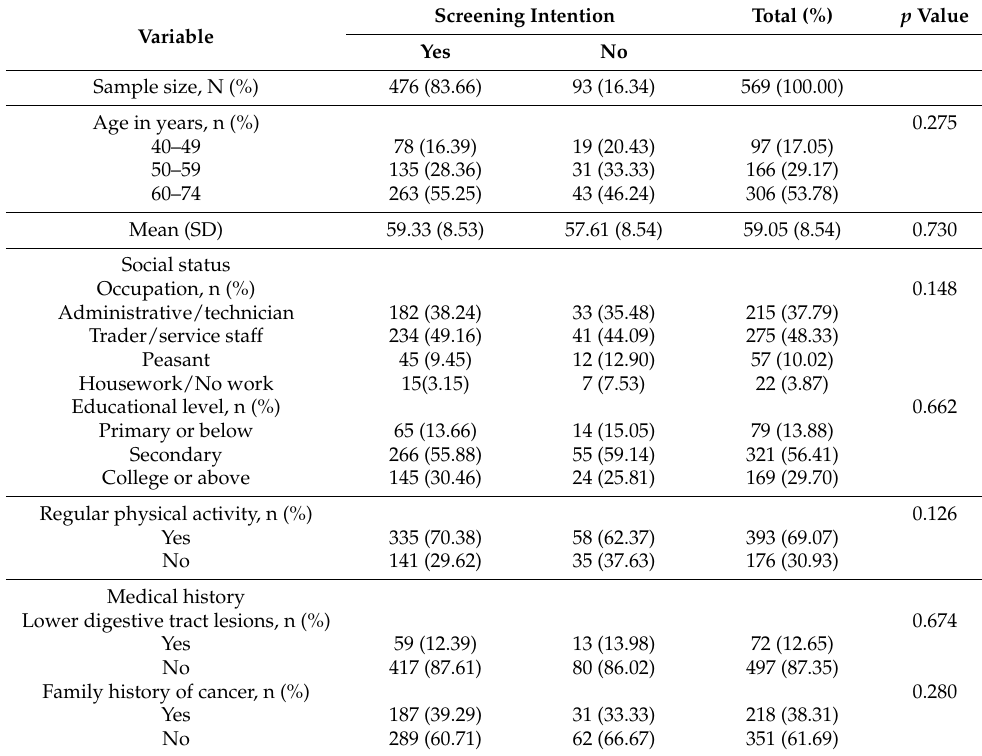
Table 1. The demographic characteristics of the study